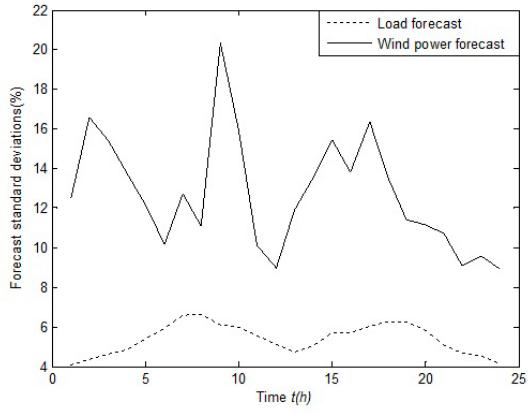
Figure 5. Standard deviations of the hourly load forecast and wind power forecast.